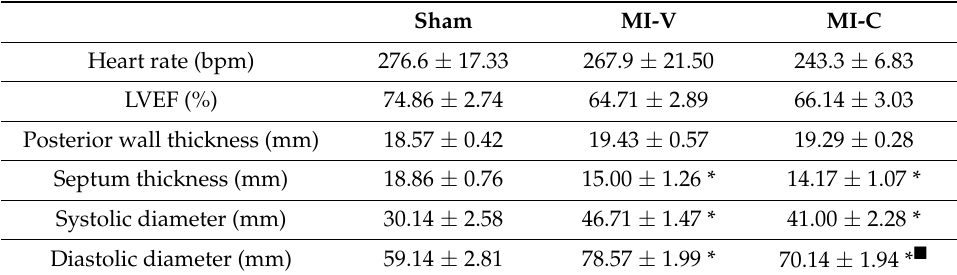
Table 1. Echocardiographic changes during MI-V and after clofibrate treatment. Table 1 shows heart rate, left ventricle ejection fraction (LVEF), left ventricle posterior wall thickness, and left ventricle systolic and diastolic diameters. Data are represented as mean ± standard error. ANOVA * p < 0.05 vs. Sham; ■ p < 0.05 vs. MI-V; n = 6 rats per group.